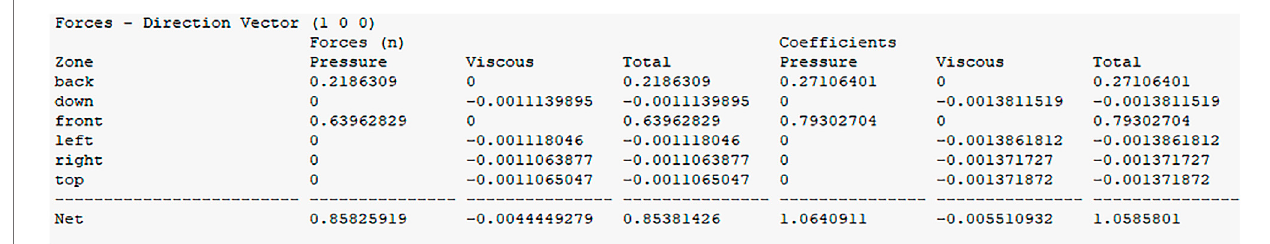
FIGURE 2 | Drag force on all